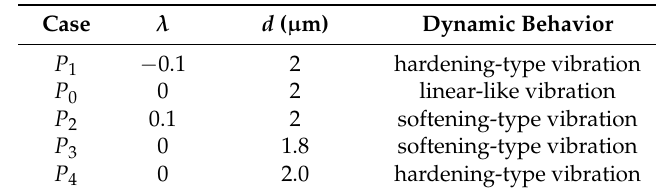
Table 1. Simulation cases under different parameters.